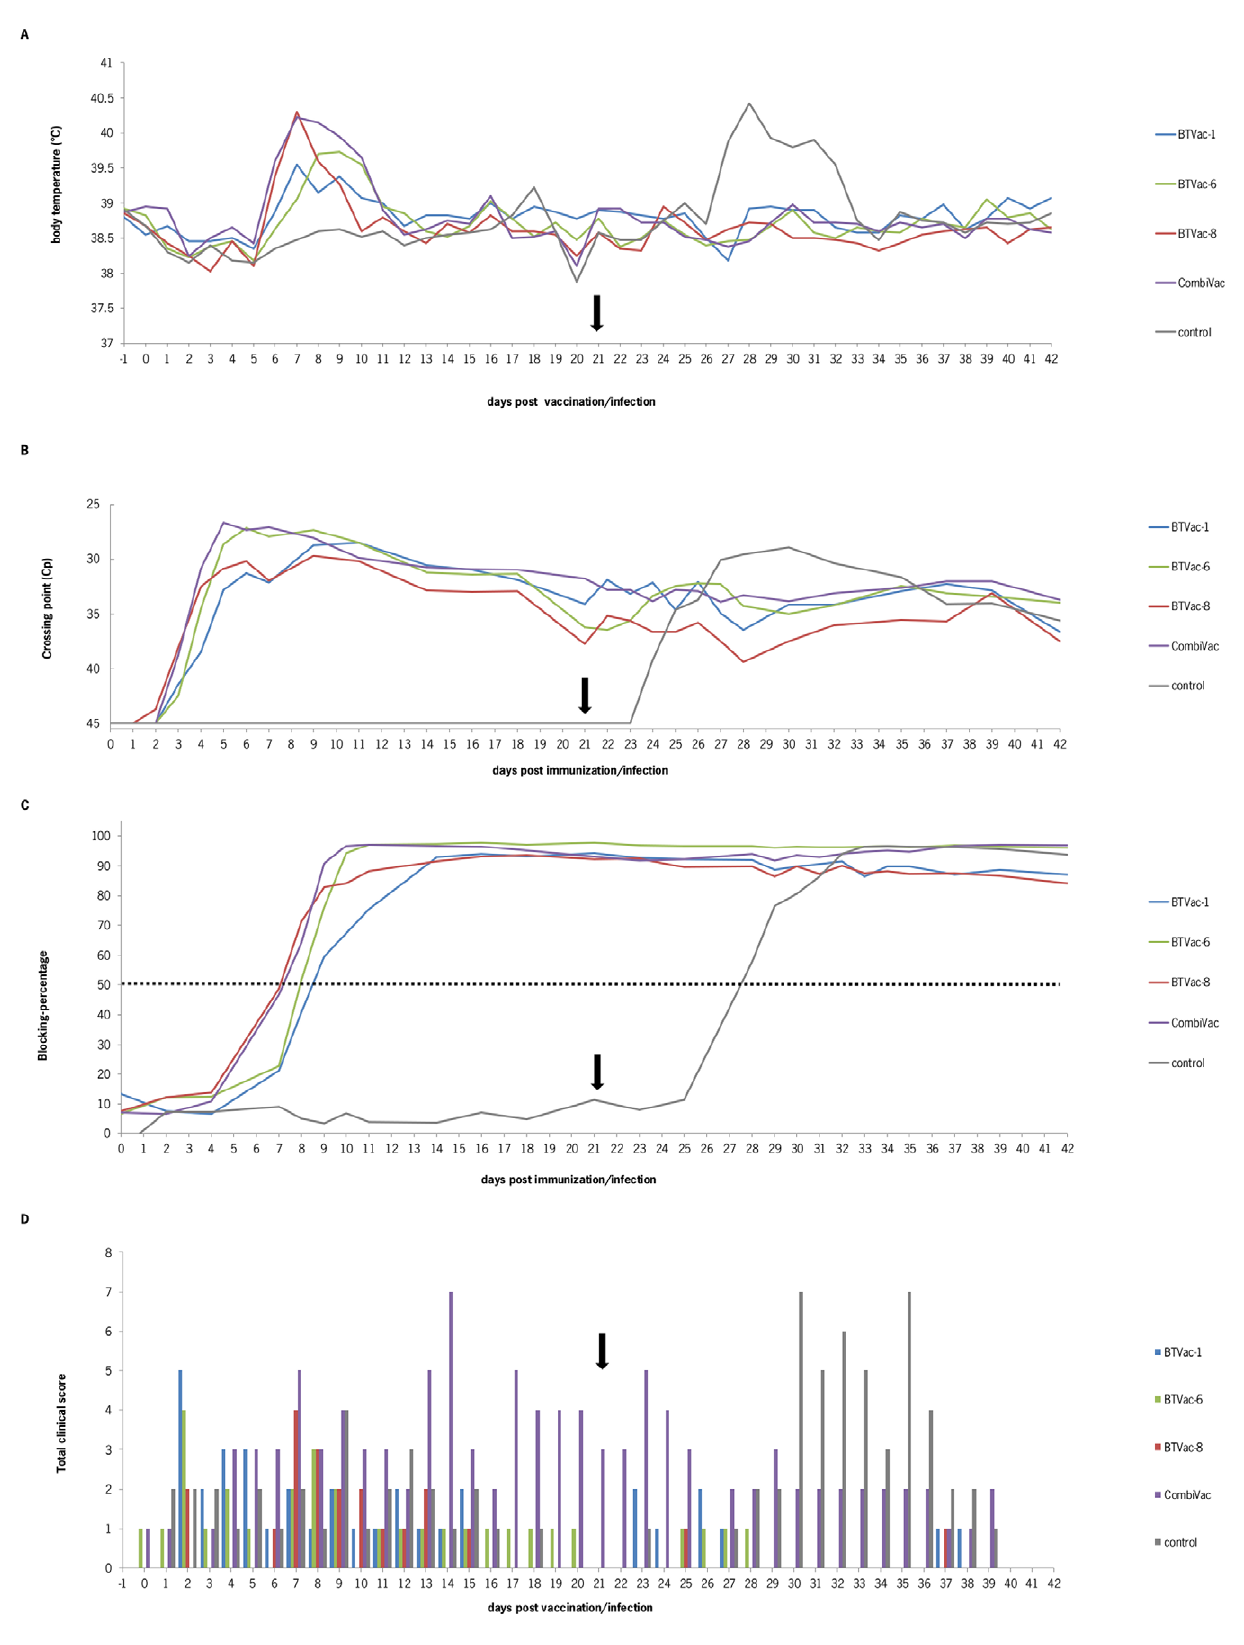
Figure 3. Vaccination/challenge experiment with serotyped BTV viruses. On day 0 (0 dpi), four sheep were intramuscularly (i.m.) vaccinated in the neck with 1 ml of 10 5 TCID 50 /ml BTVac-1, 1 ml of 10 1.4 TCID 50 /ml BTVac-6, or 1 ml of 10 5 TCID 50 /ml BTVac-8. A fourth group was vaccinated